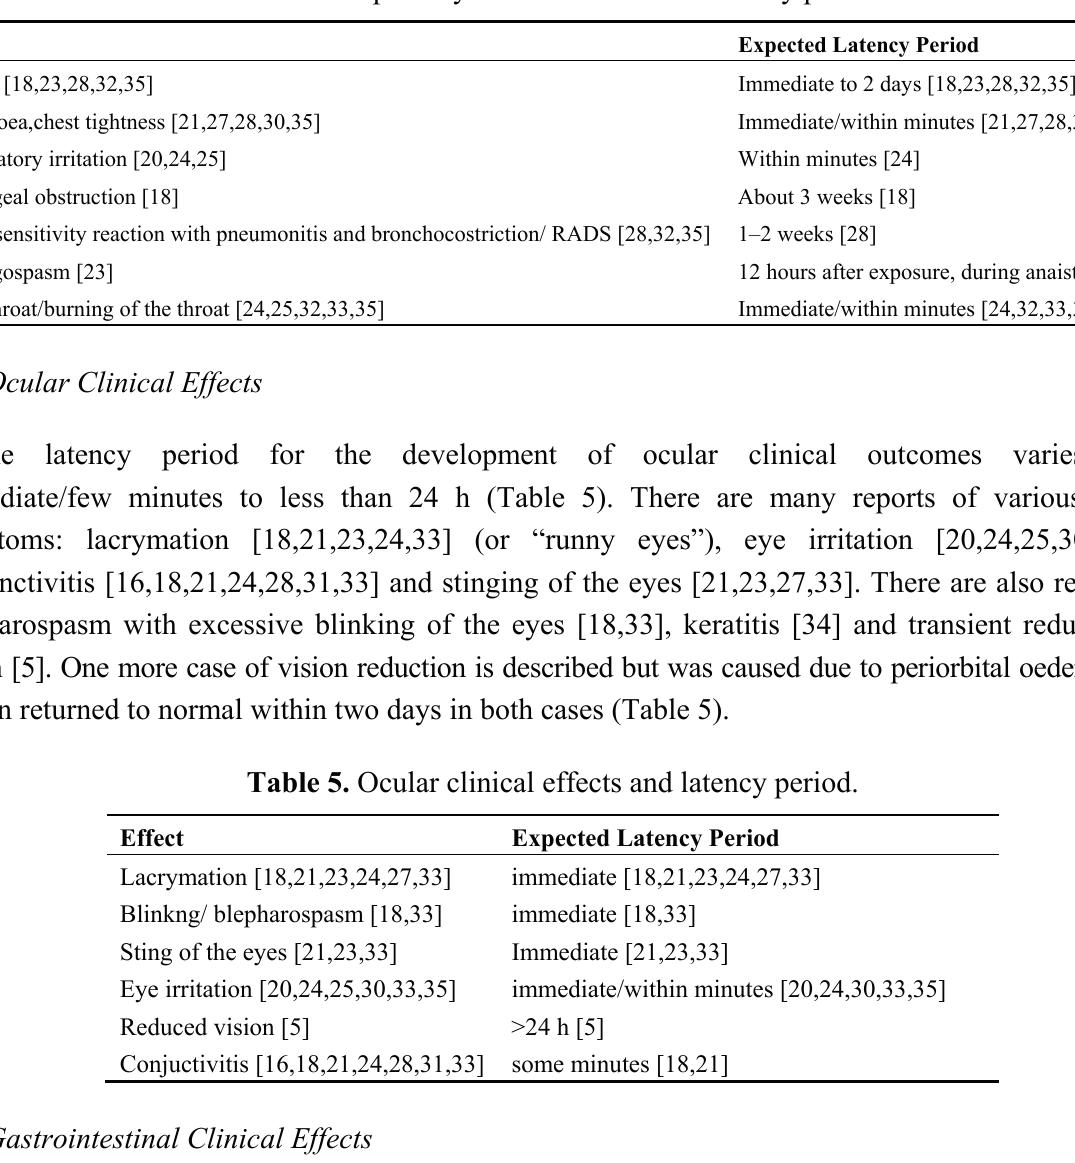
Table 4. Respiratory clinical effects and latency period.